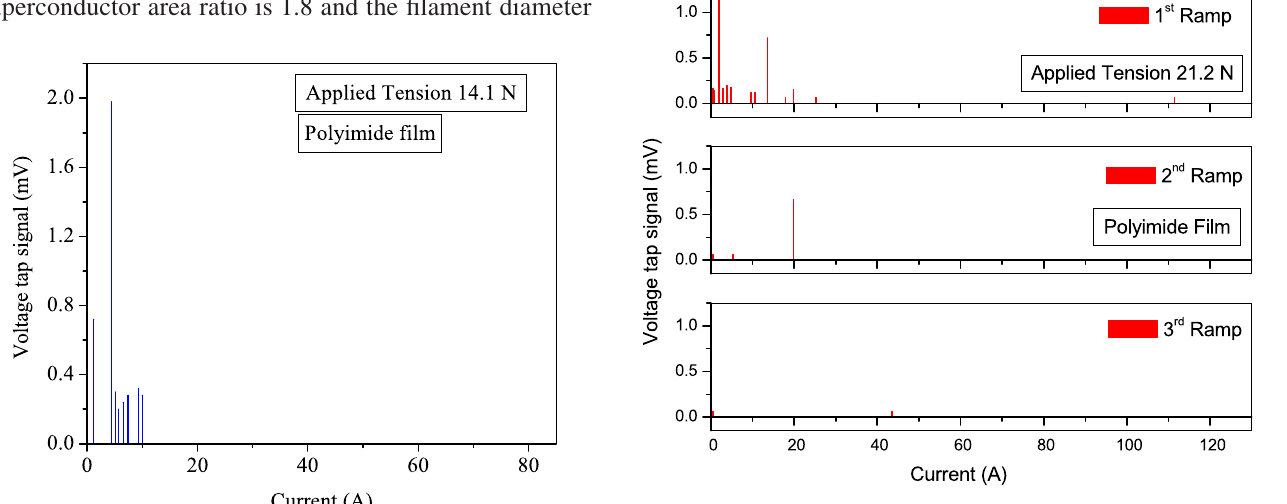
FIG. 3. (Color) Training effect as observed in the case of poly- imide